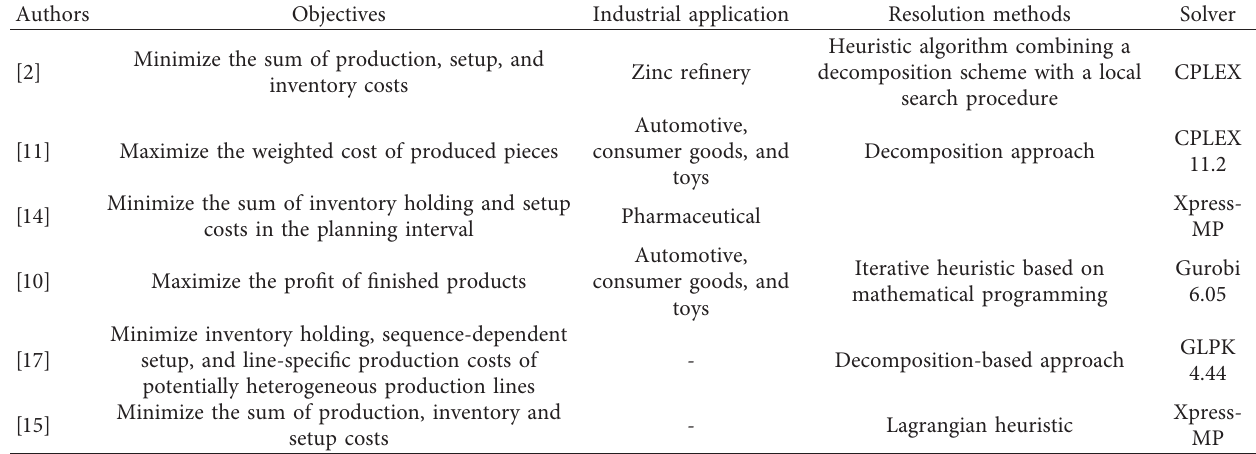
Table 1: Literature review of recent lot-sizing and scheduling